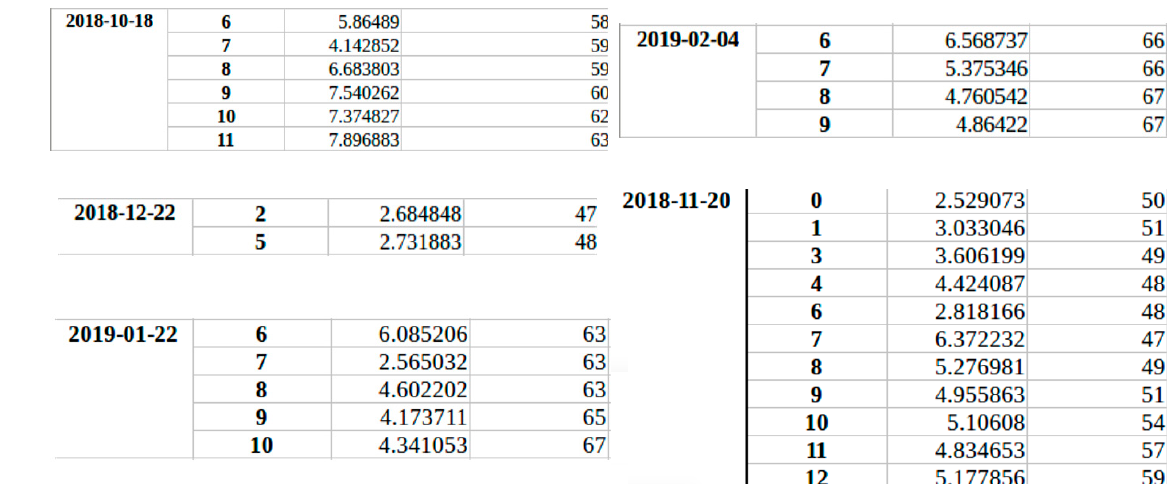
Figure 15. A sample of days with high HVAC consumption when the outdoor temperature was low .